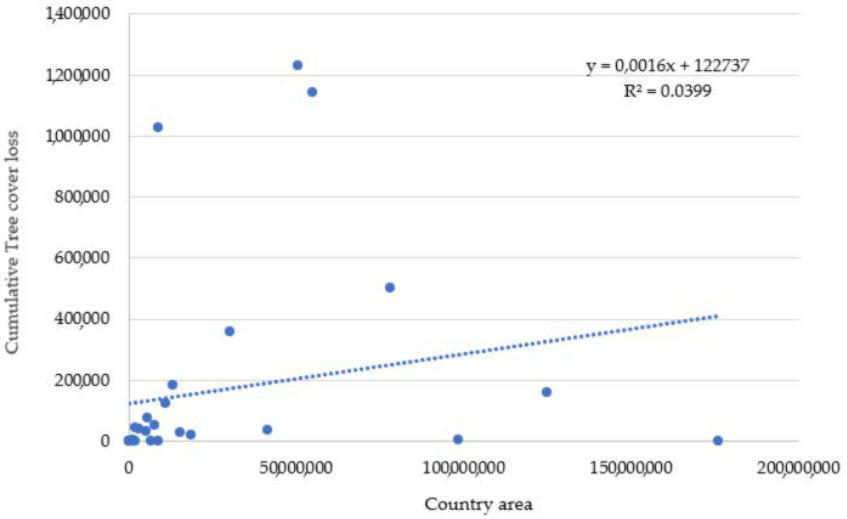
Figure 7. Relation between country area and tree cover loss area.